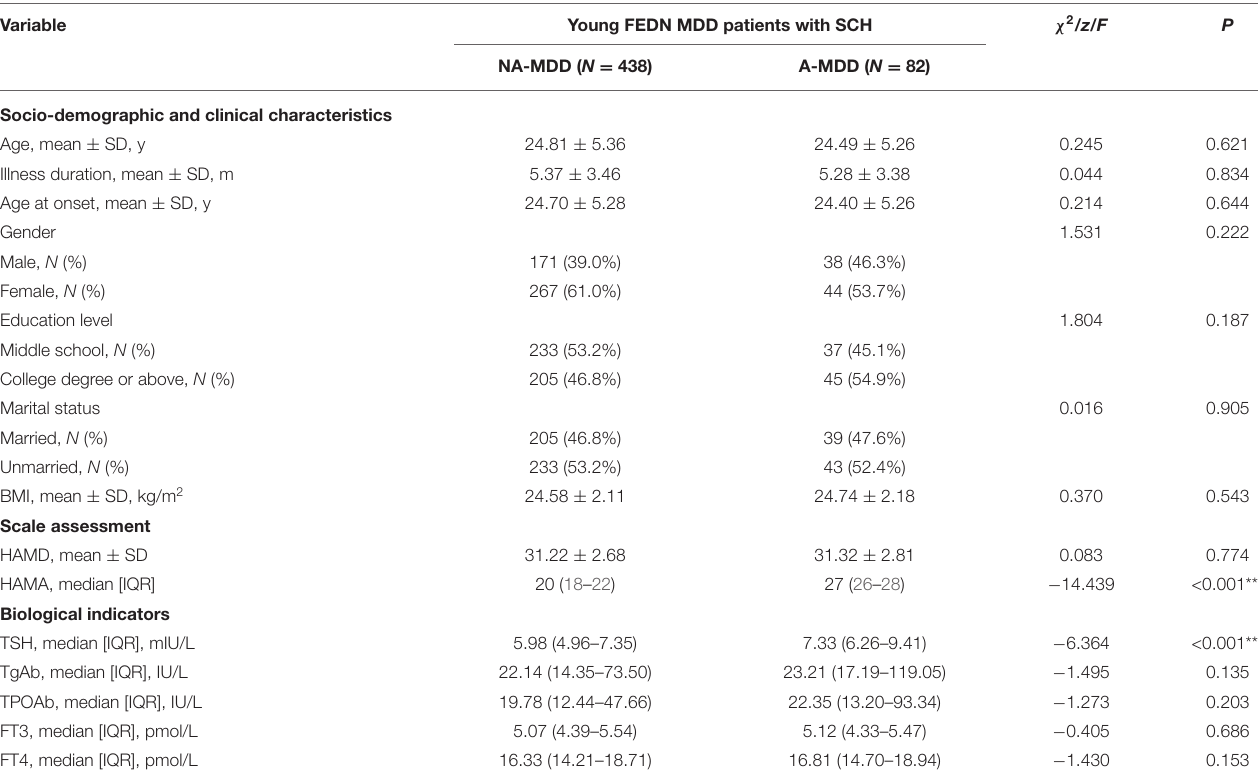
TABLE 1 | Socio-demographical and clinical characteristics of the participants. Variable